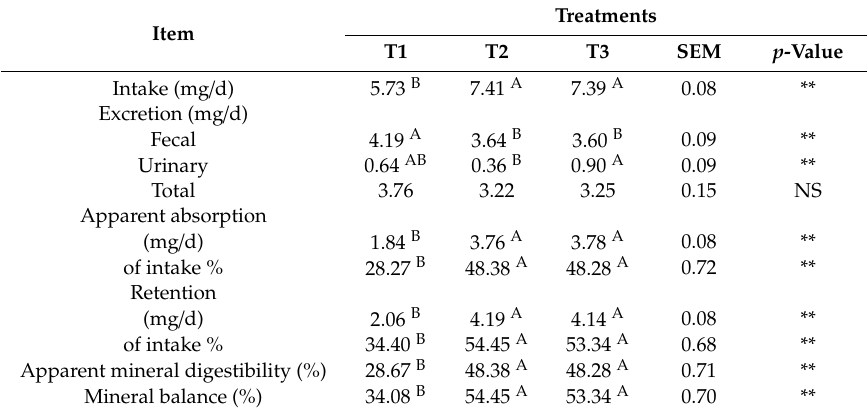
Table 2. Copper balance by Dorper lambs fed with di ff erent levels of